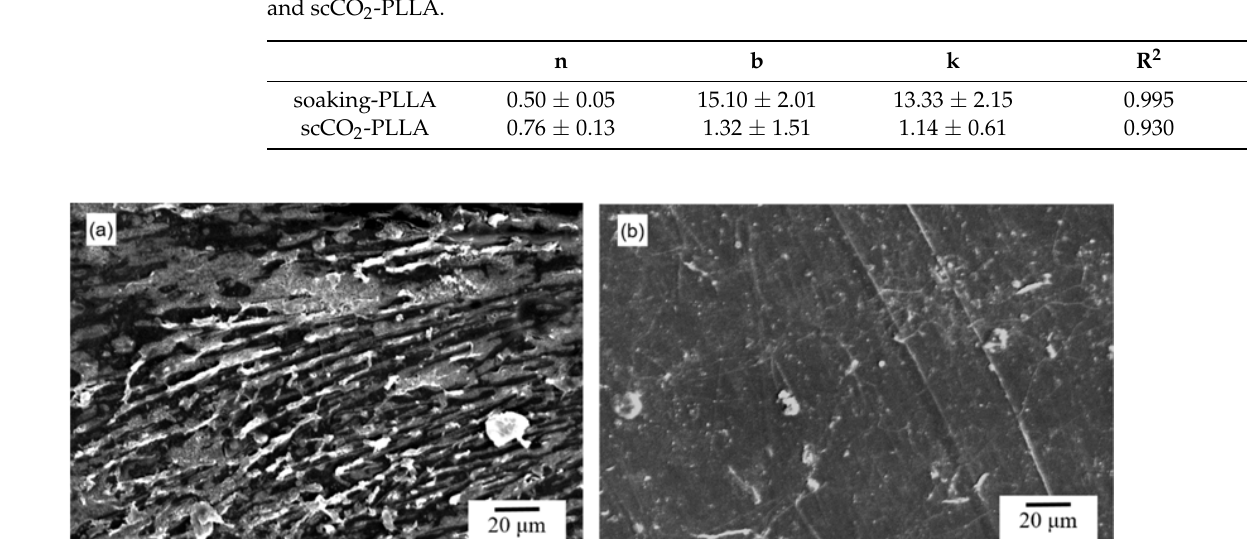
Figure 10. Comparison of the release profile of aspirin from soaking-PLLA and scCO 2 -PLLA samples, ( a ) cumulative release and ( b ) quantity of aspirin released. Table 5. Release kinetic parameters obtained from the Korsmeyer–Peppas model for soaking- PLLA and scCO 2 -PLLA.